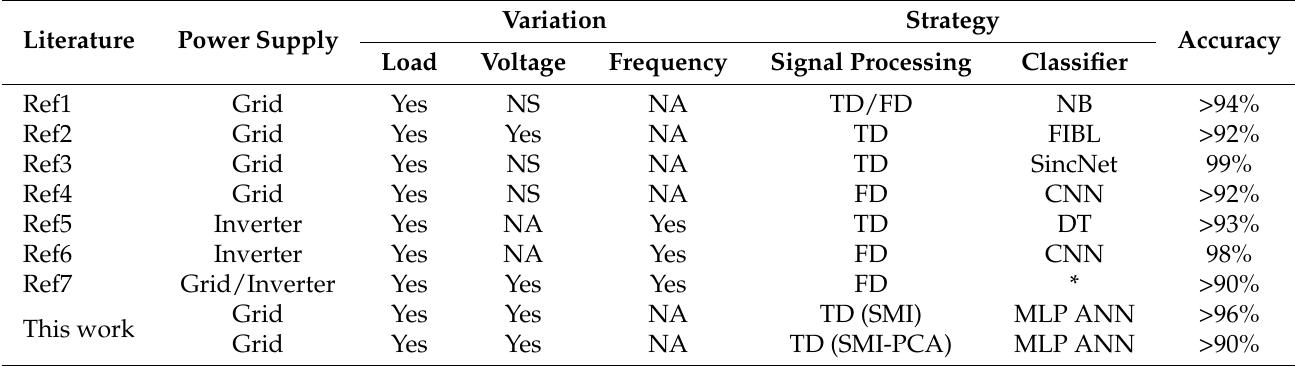
Table 12. Comparison of the proposed approach with recent studies of multiple fault diagnosis in